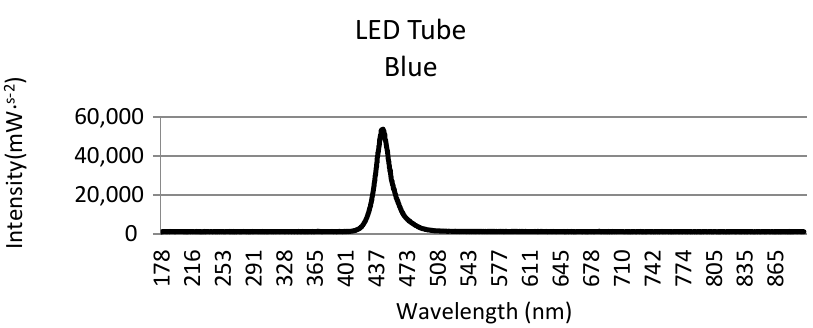
Figure 3. Spectral characteristic of blue light. Figure 2. Spectral characteristic of white light.